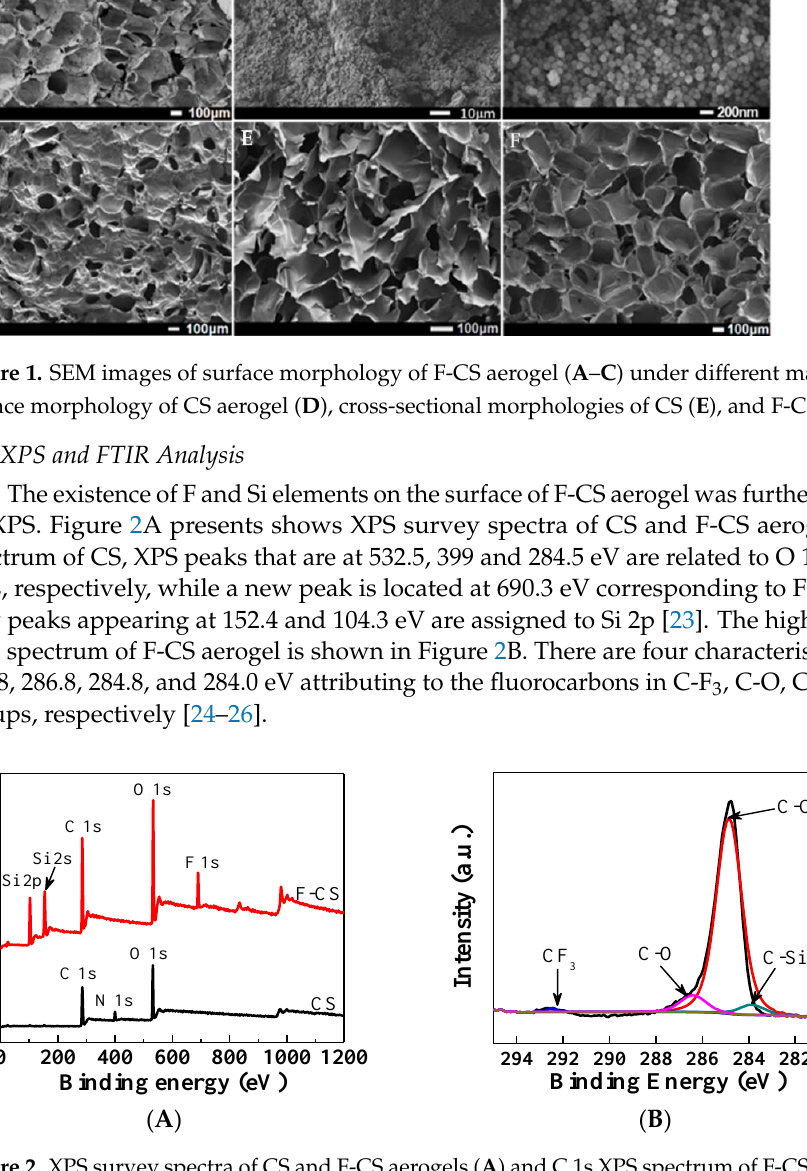
Figure 2. XPS survey spectra of CS and F-CS aerogels ( A ) and C 1s XPS spectrum of F-CS aerogels ( B ) .